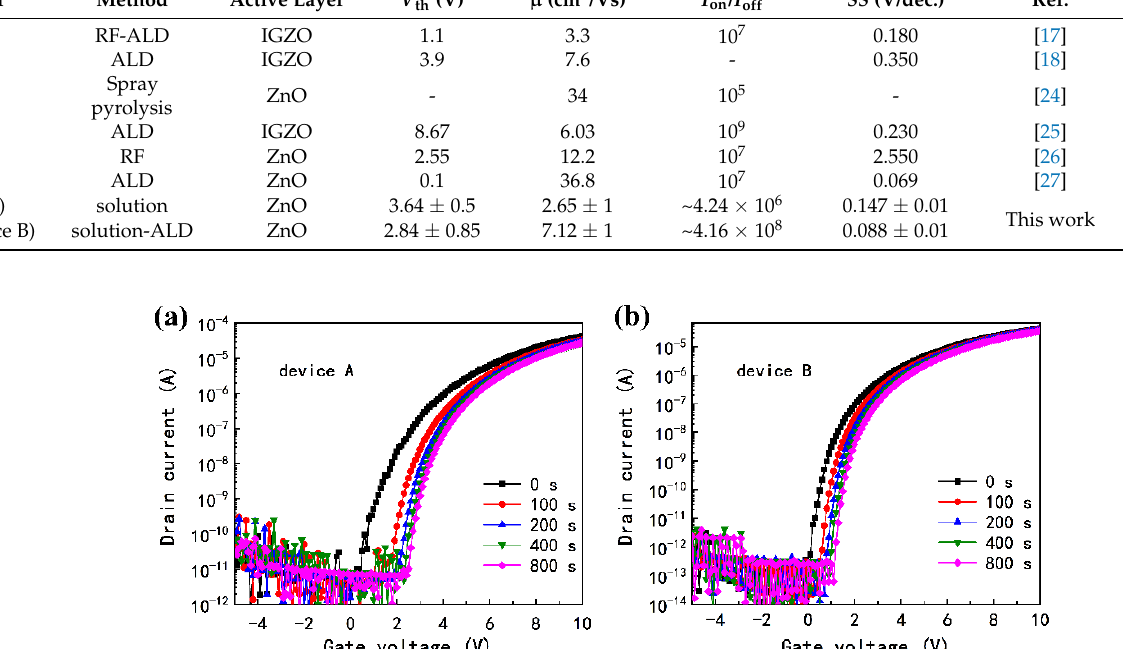
Figure 5. ( a ) Positive bias stress of device A and ( b ) Positive bias stress of device B. Figure 6 shows the threshold voltage shift ( ∆ V th ) of device A and B under different stress times. The values of ∆ V th for the device A and B are 1.4 and 0.7 V, respectively. The smaller ∆ V th indicates that the Y 2 O 3 –Al 2 O 3 laminated dielectric layer has a lower surface defect state density. The ∆ V th dependence of time agrees with a stretched-exponential equation: